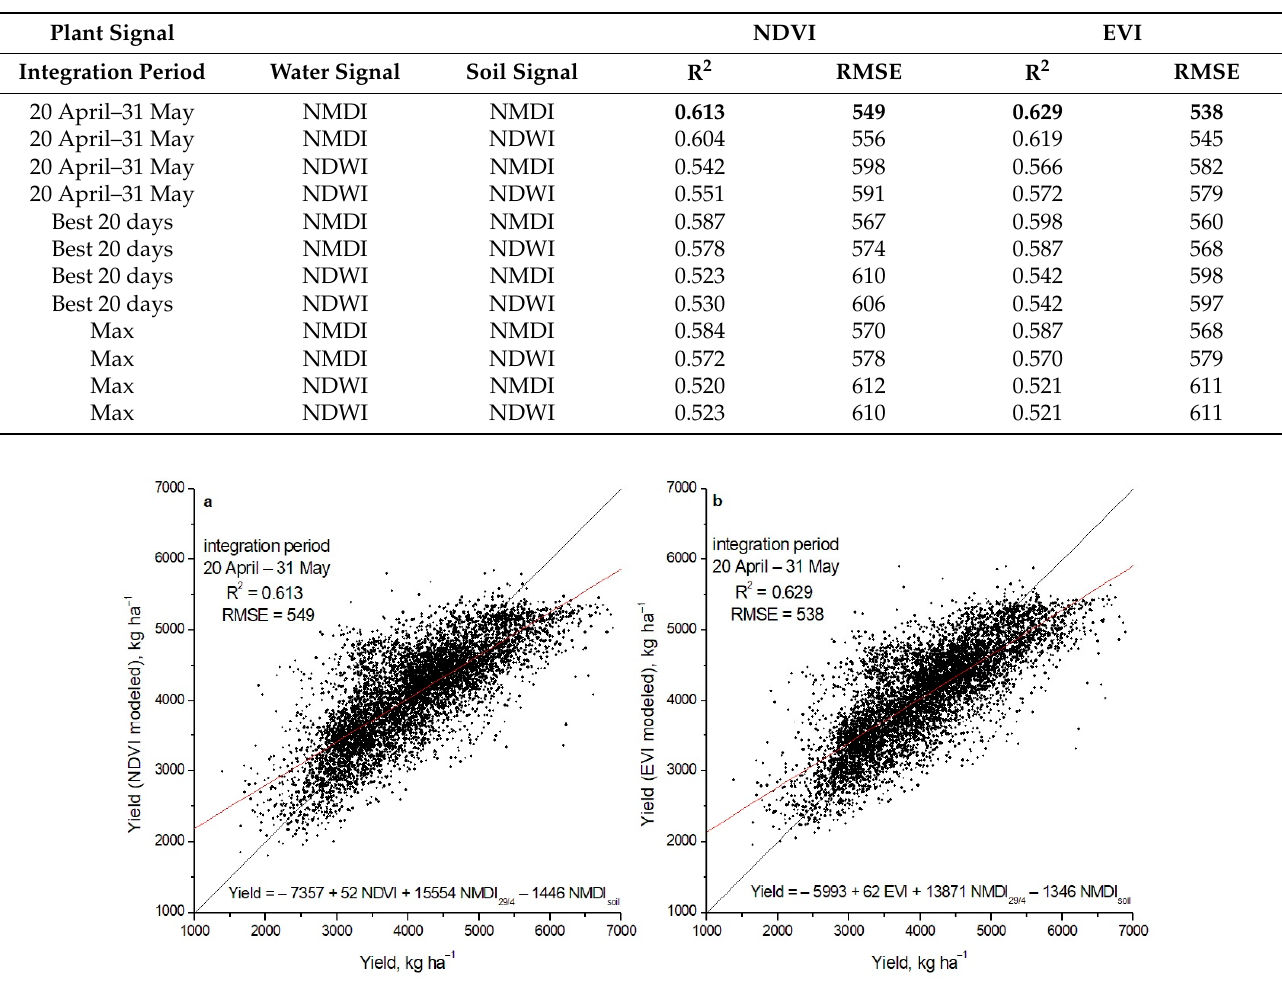
Figure 12. Relationships between measured yield and best model estimates based on NDVI ( a ) or EVI ( b ) as plant signal. For both models, water and soil signals correspond to NDWI on 29 April and NDWI before sowing accordingly. Data concern 31 fields during two growing periods, corresponding to 7436 pixels. The black line corresponds to the 1:1 line and the red is the best-fit line. The equations of the modelled yield obtained from the multiple linear regressions are indicated in the graphs.